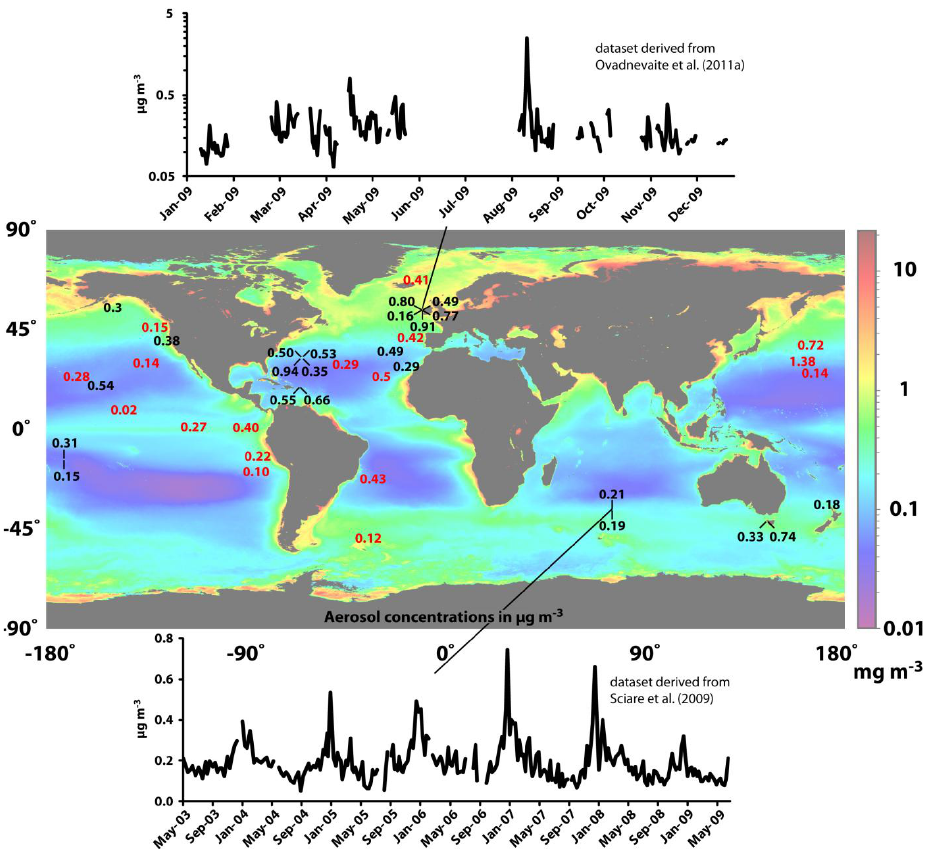
Figure 1. Climatological (1997-2010) chlorophyll- a concentration (mg m -3 ) from the Sea-viewing Wide Field-of-view Sensor (SeaWiFS) superimposed with observed organic aerosol concentrations (µg m -3 ) averaged from coastal sites (black) and regionally-averaged from ship cruises (red) in clean marine conditions. See supplementary Table S1 for measurement details and references.